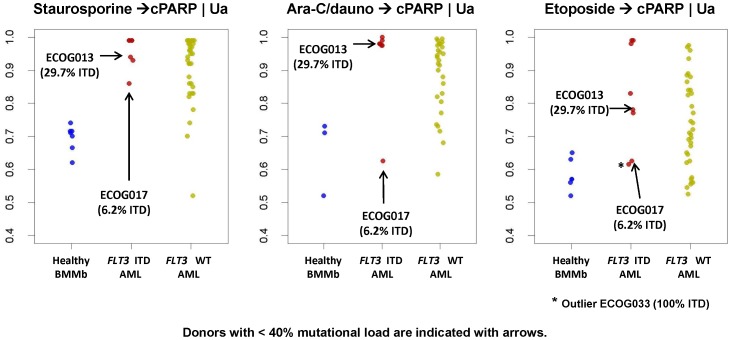

In vitro apoptosis responses in FLT3 ITD samples.Staurosporine→cPARP Ua metric (left graph), Ara-C/Daunorubicin→cPARP Ua metric (middle graph), and etoposide→cPARP Ua metric (right graph) for healthy (left), FLT3 ITD (middle) and FLT3 WT (right) bone marrow. Samples with low mutational load (<40%) are identified with an arrow.